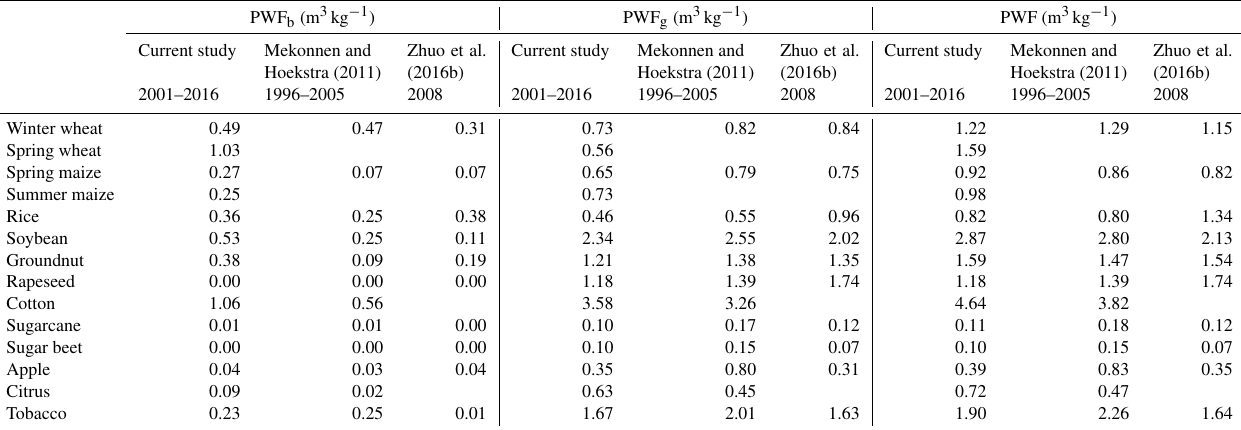
Table 5. Comparison between production-based water footprint (PWF) of crop production in mainland China in the current study and previous studies.